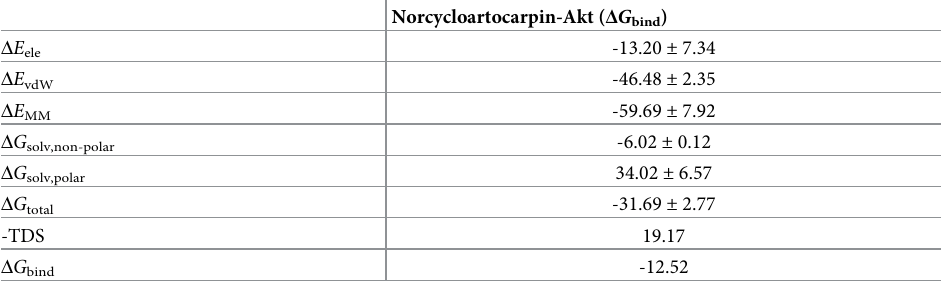
Table 1. The MM/GBSA ( Δ G bind ) and its energy components (kcal/mol) of the norcycloartocarpin-Akt